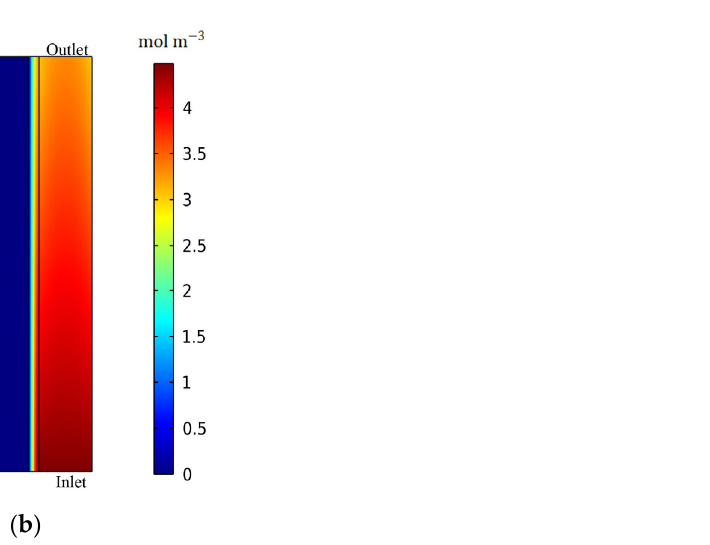
Figure 16. Comparison of the bromine concentration distribution in the positive electrode at 0.9 h at a current density of 20 mA cm − 2 : ( a ) Pristine and ( b ) Optimization.